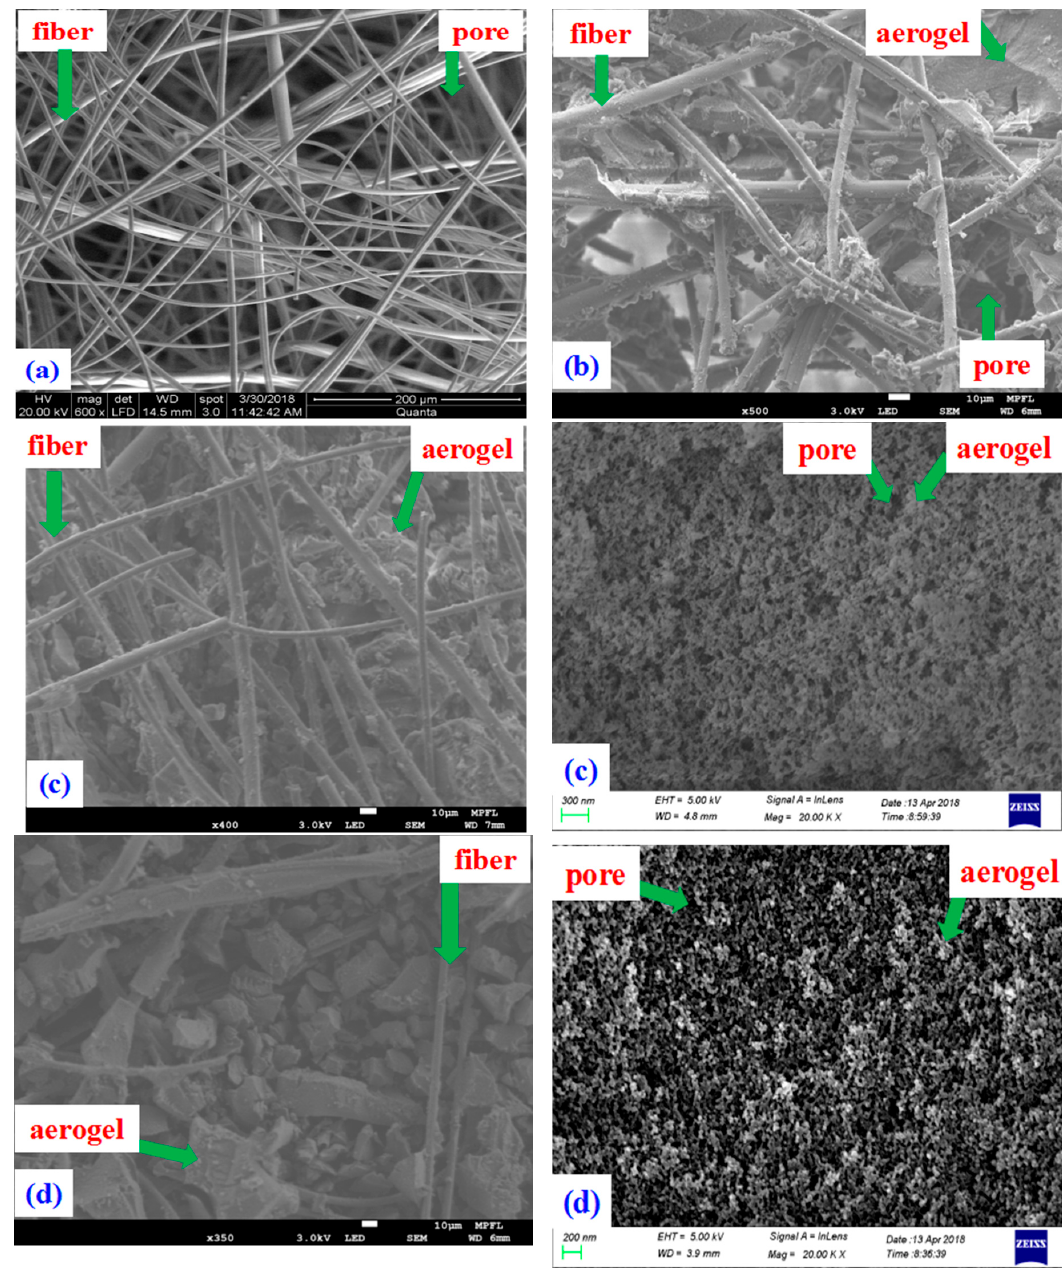
Figure 4. SEM of different porous materials. ( a ) Sample 17 Fiber mat (FEI-Quanta400); ( b ) Sample 16 Fiber mat-aerogel (JEOL-7800F); ( c ) Sample 8 30% ZrO 2 -fiber mat-aerogel (left: JEOL-7800F, right: